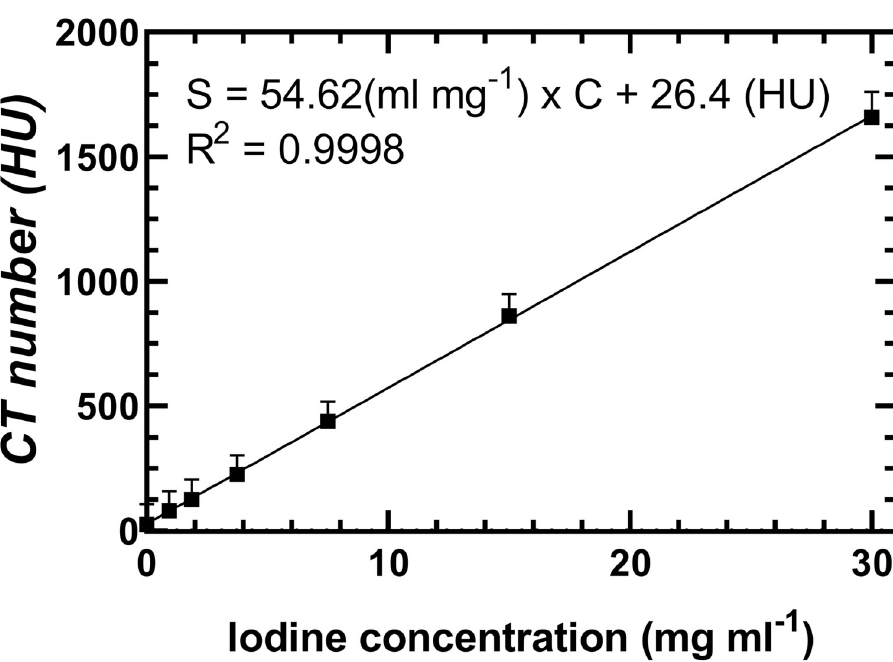
Fig 13. Plot of measured CT number within ROIs placed in each iodine vial versus known iodine concentration within the linearity plate of the CT quality assurance phantom. A significant linear correlation is seen between CT number in HU and iodine concentration in mg ml -1